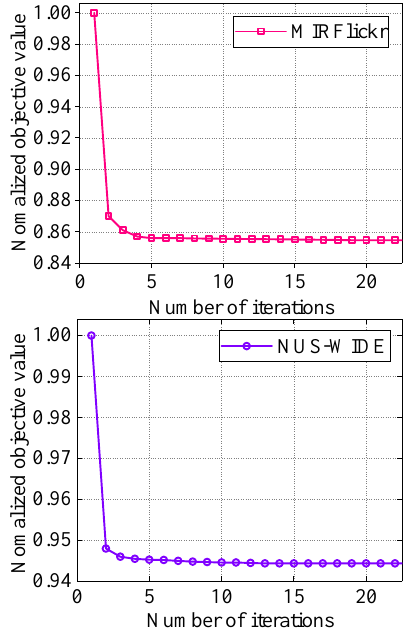
Figure 5. Convergence curves of DSAH on two datasets with 64